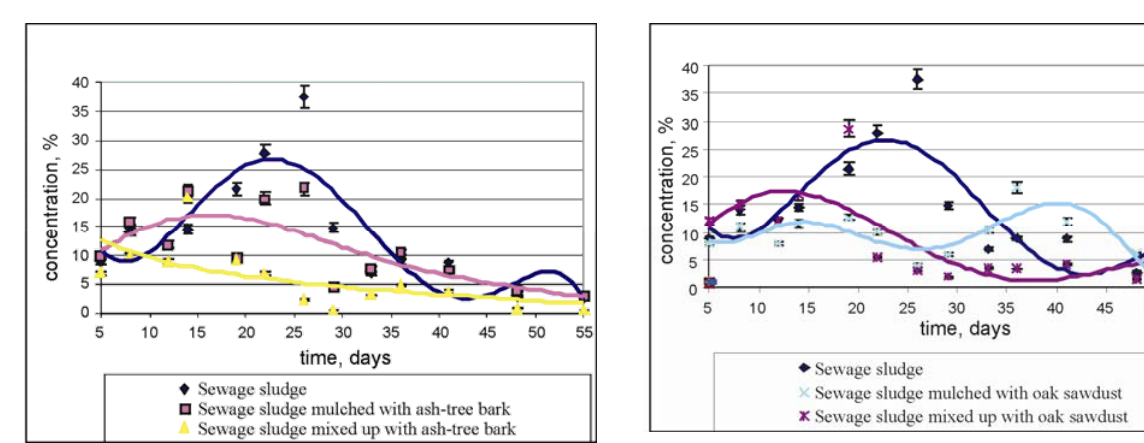
Fig. 8. Methane gas emissions during composting sewage sludge with ash-tree bark